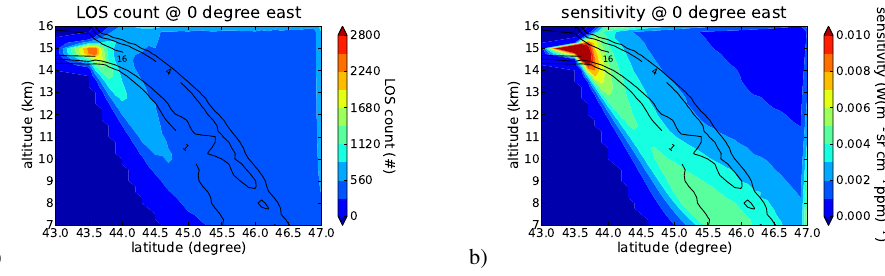
Fig. 4. The spatial distribution of measurements. Panel (a) shows for each volume element of the cutting plane the number of measurements sampling it. In panel (b) , the sum over the absolute values of the columns of the Jacobian matrix is depicted. The number of tangent points within the depicted volume elements is overlaid as a contour plot.